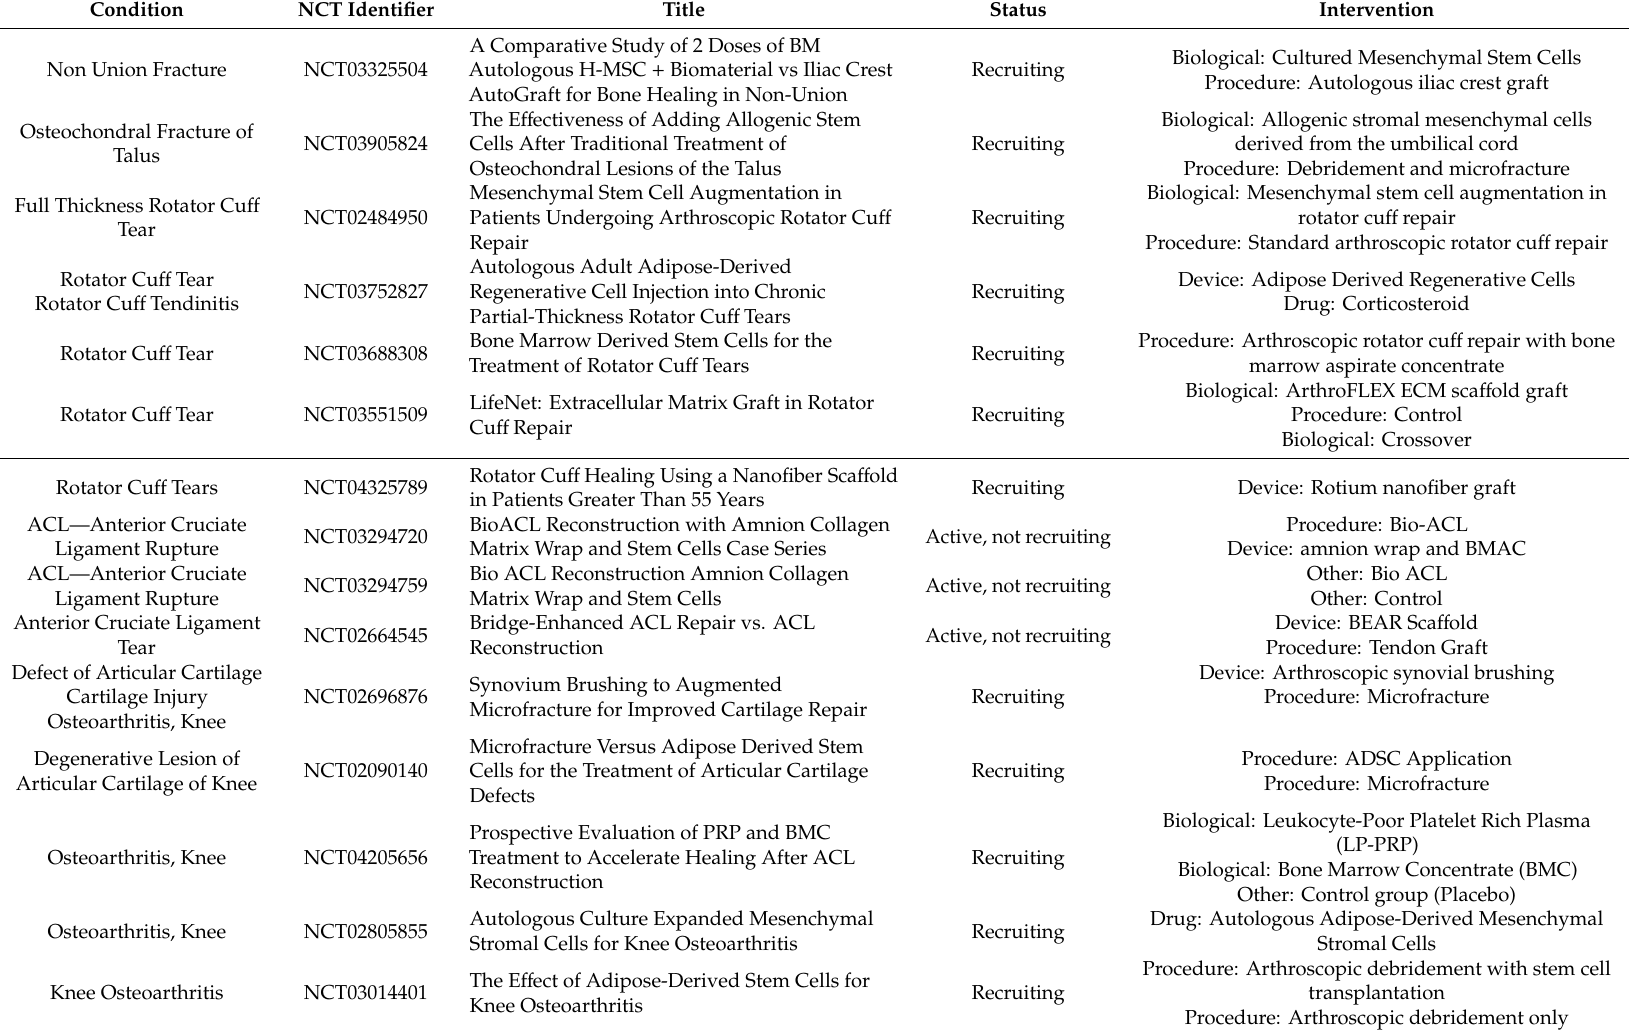
Table 2. List of few ongoing clinical trials for skeletal